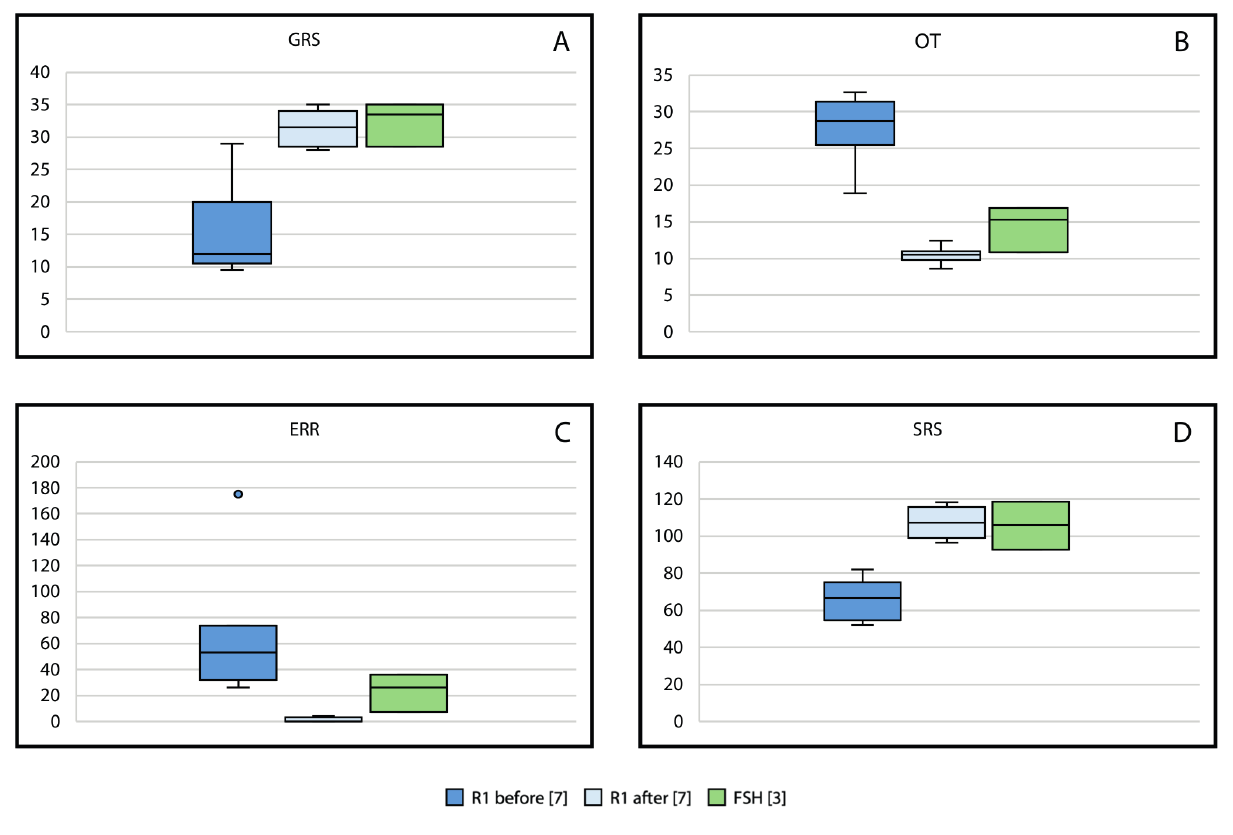
Figure 4. Boxplots showing junior residents (R1)’ GRS (A), OT (B), ERR (C), and SRS (D), before and after training, and compared to fellowship-trained rhinologists (FSH) performance. Brackets: participants per